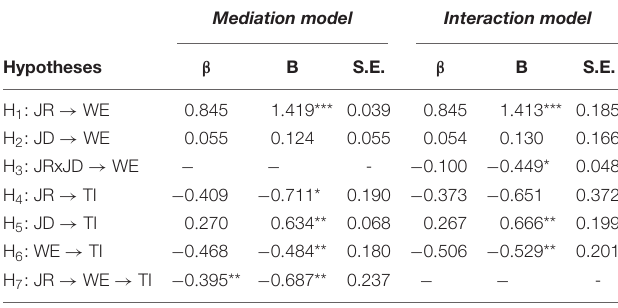
TABLE 3 | Fit indices for the mediation and interaction models.